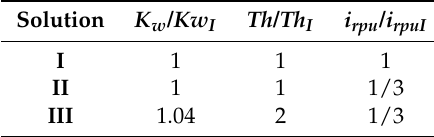
Table 1. Differences among